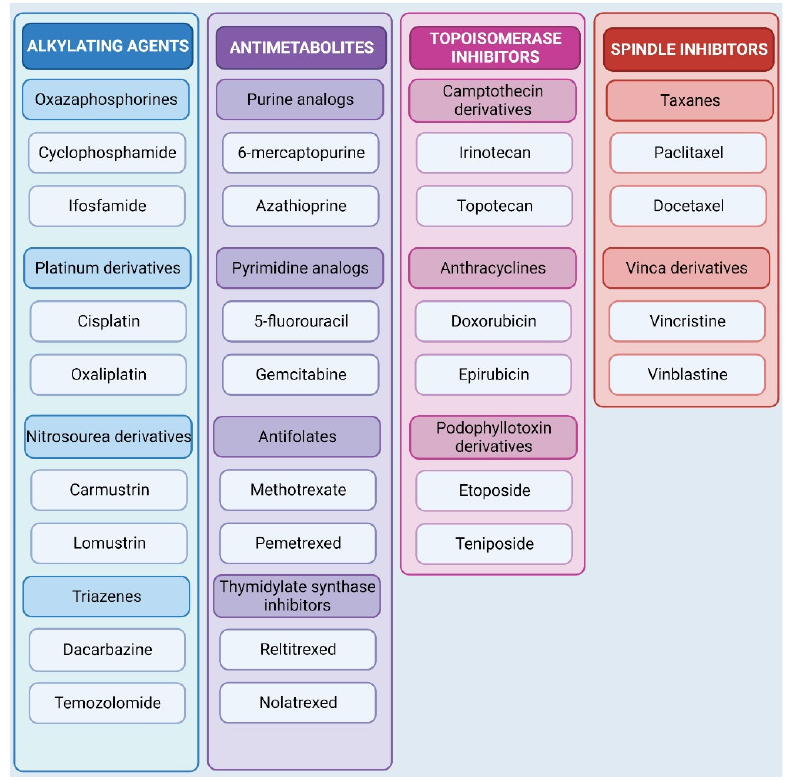
Figure 1. The main types of chemotherapeutics sorted by their mechanism of action. Among the most popular are alkylating compounds, antimetabolites, topoisomerase inhibitors, and mitotic spindle inhibitors. Created with BioRender.com (accessed on 22 March 2023).